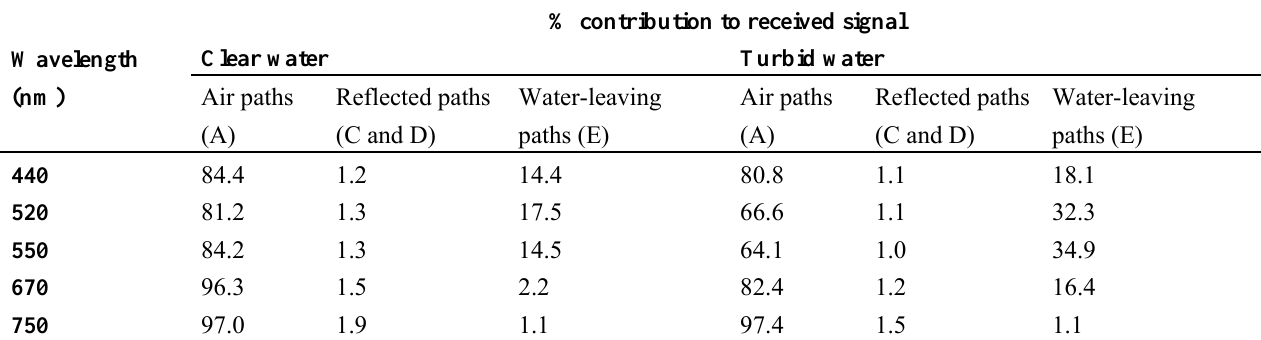
% contribution to received